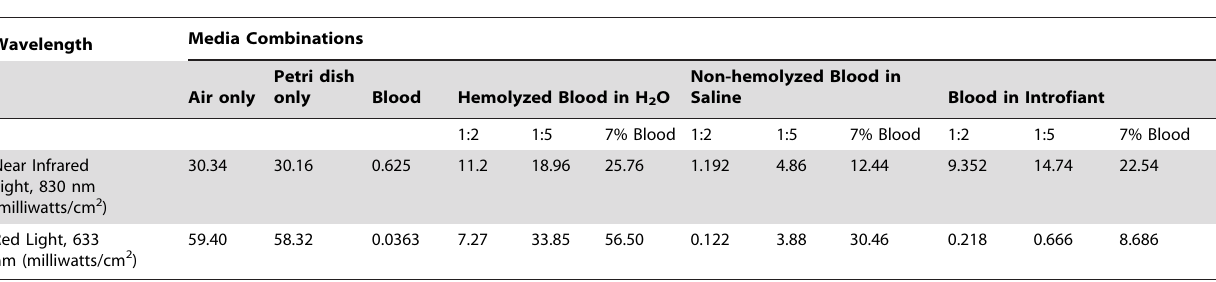
Table 3. Transmission of Near Infrared and Red Light through Various Concentrations of Blood.